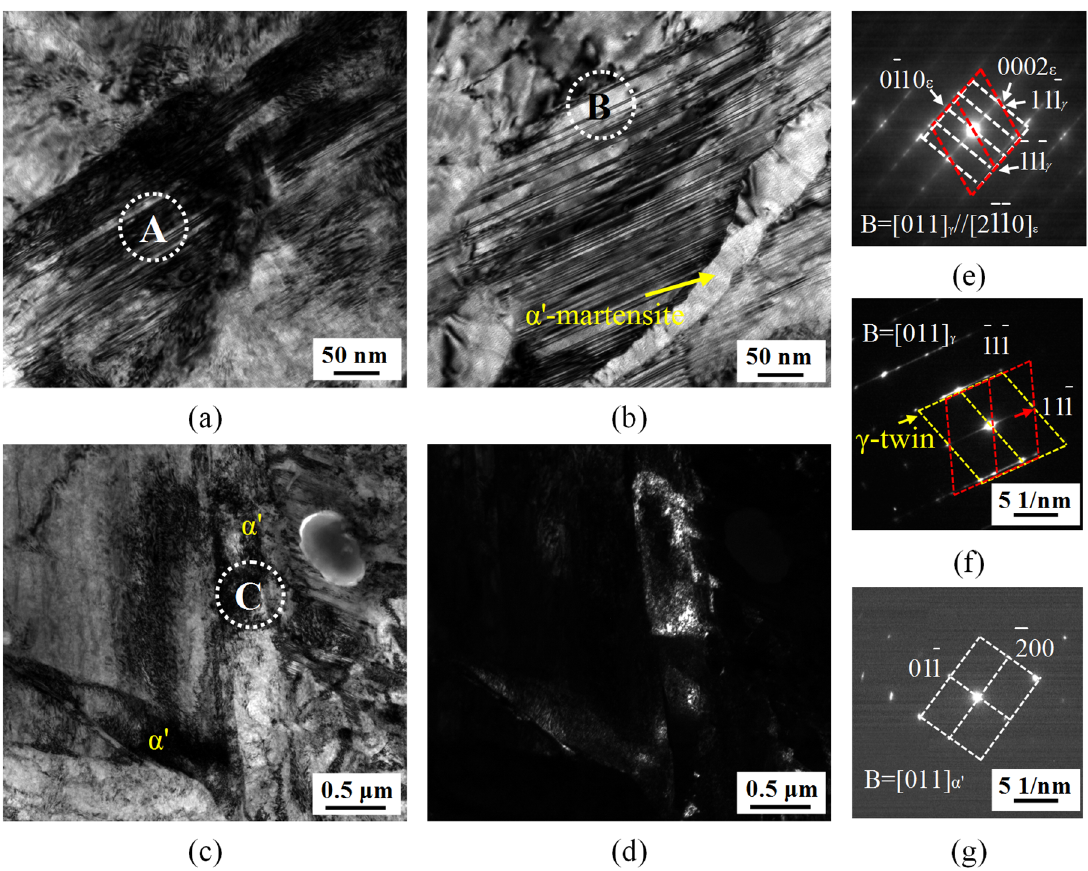
Figure 7. TEM micrographs of the Fe-19Mn-8Cr-1Co-0.2Si alloy after 20% cold rolling deformation: (a), (b) and (c) the bright-field image, showing high density dislocations; (d) the corresponding dark-field image obtained from (01-1) α' diffraction spot; (e), (f) and (g) the SAEDP obtained from the region A, B and C